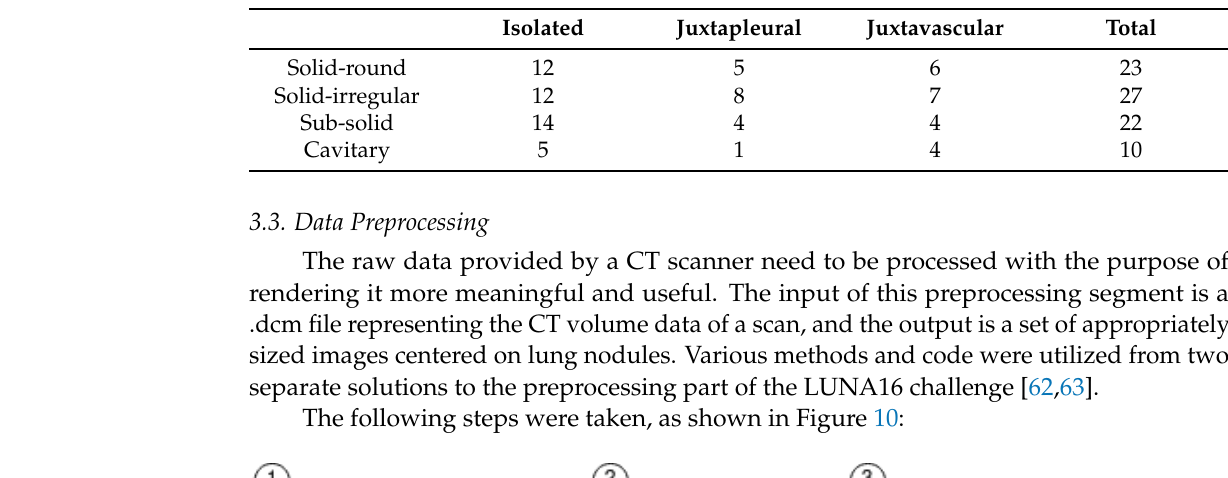
Table 4. The number of cases in each category and subcategory of the LIDC subset.